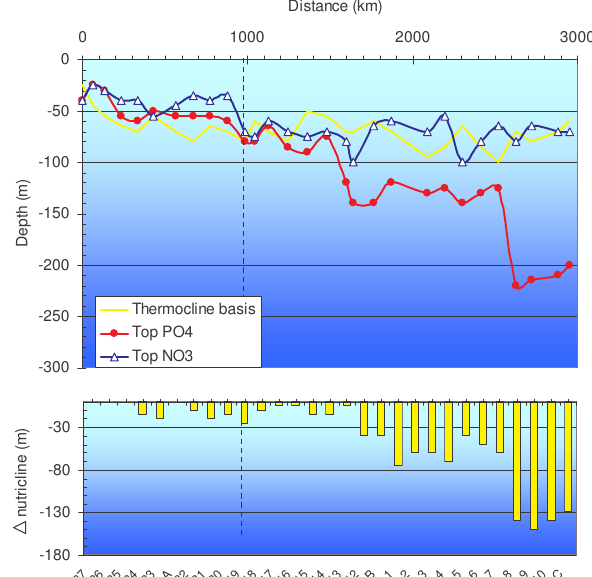
Figure 4. Evolution of the depth of the thermocline basis, and the top of the nitracline and phosphacline along the BOUM transect. The vertical dashed line separates the western and the eastern basins. On the X-axis, the position of the stations is indicated. The thermocline basis for temperature and the top for the nutriclines are defined for the depth where the difference in concentration or temperature between two successive depths exceeds a threshold of 0.05 and 0.02 for NO 3 and PO 4 respectively, or fall under a threshold of 0.4 for temperature. The histogram shows the difference between the depths of the nitracline and phosphacline along the transect.